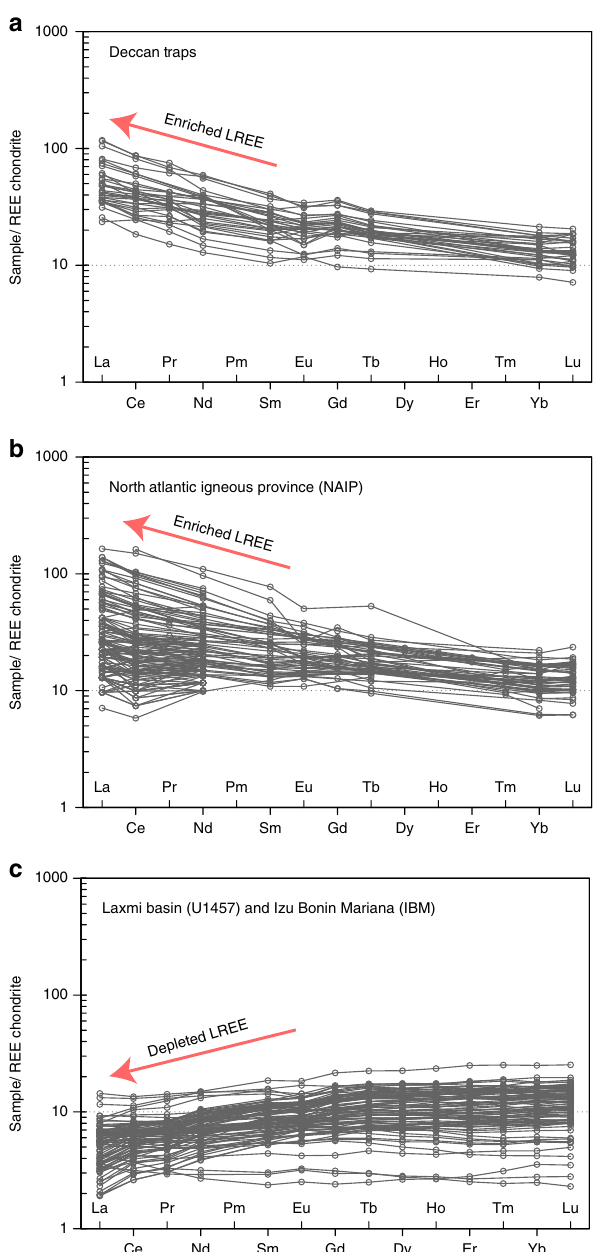
Fig. 1 REE variations of different lava types. Chondrite – normalized rare earth element variations of different lava types. a – c The above diagram highlights characteristic differences among lavas from different tectonic regimes as labelled. Arrows indicate general enrichment/depletion trends.